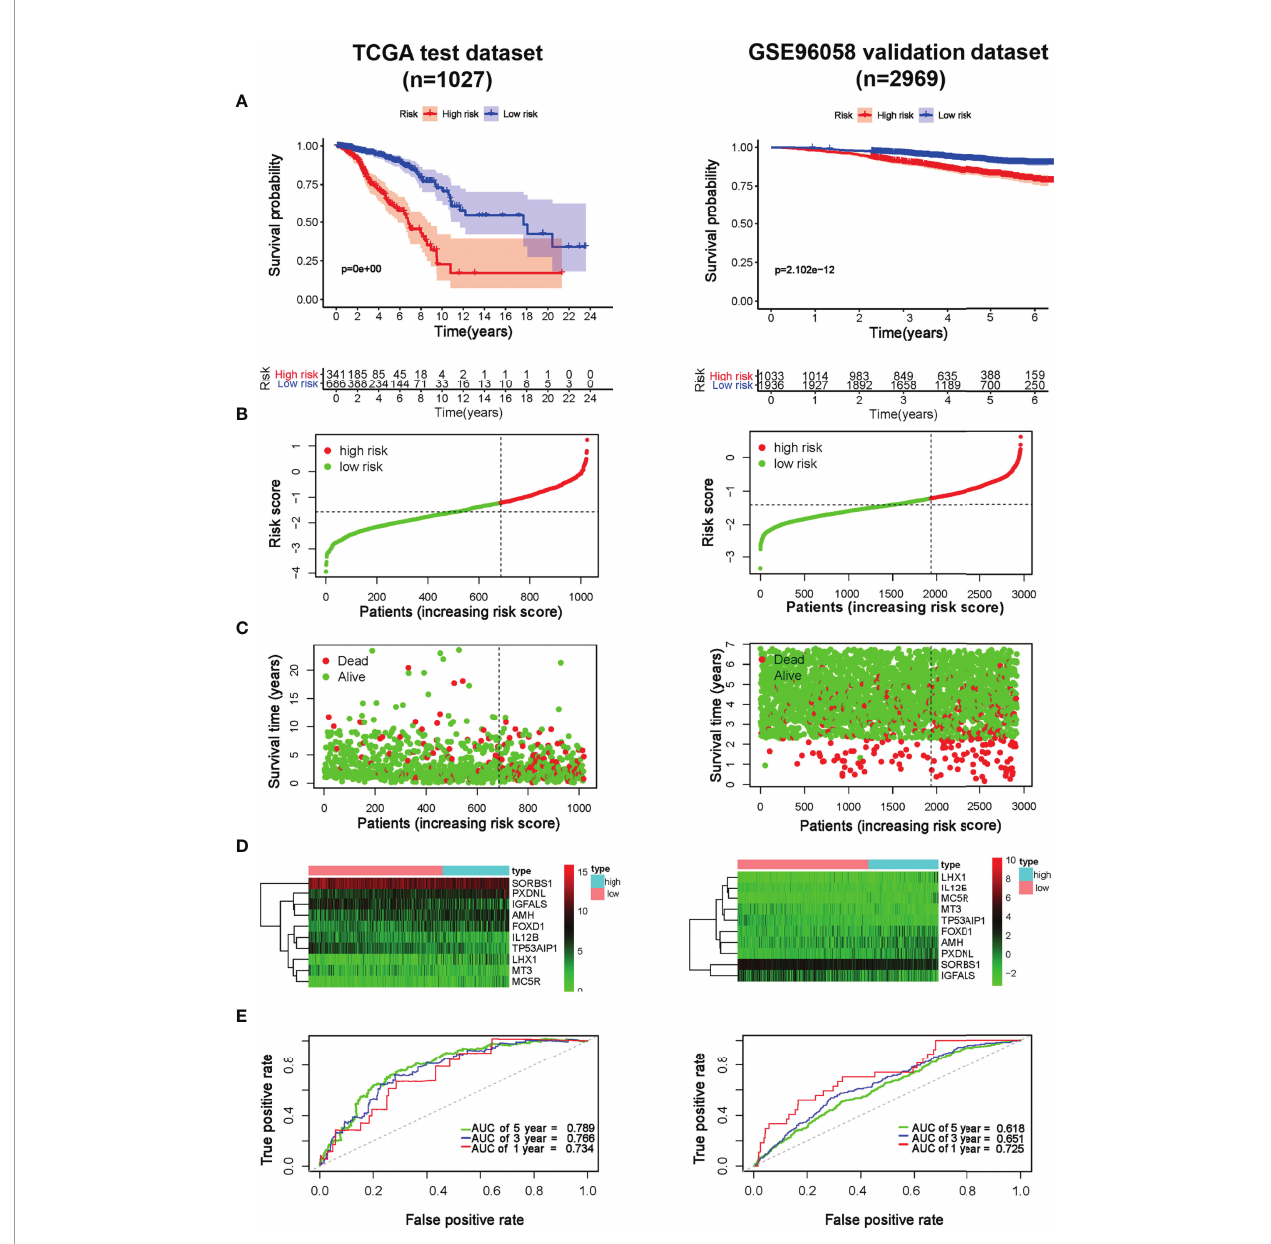
FIGURE 3 | Prognostic effect of the model in breast cancer. (A) Kaplan-Meier OS curves of breast cancer patients in TCGA and GSE96058 cohorts; (B) The distribution of risk score of breast cancer patients in TCGA and GSE96058 cohorts. X ‐ axis here is patient number and Y ‐ axis is risk score; (C) Survival status of the patients with different risk score in TCGA and GSE96058 cohorts. X ‐ axis here is patient number and Y ‐ axis is survival time; (D) A heatmap showing 10 gene expression pro fi les in TCGA and GSE96058 cohorts; (E) ROC Analysis of the risk model in TCGA and GSE96058